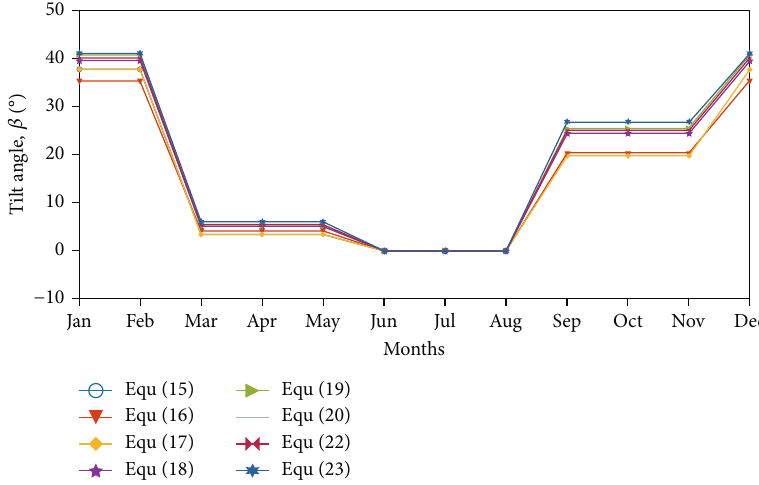
Figure 7: Seasonal optimal tilt angle evaluated by isotropic and anisotropic models for Bahir Dar city.